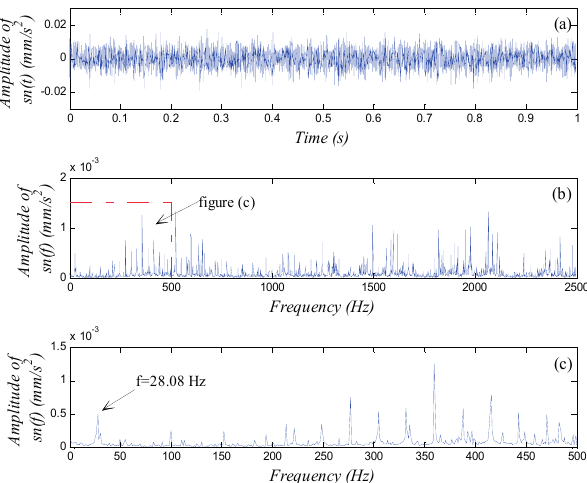
Figure 7. Vibration signal analysis of shaft-bending fault: ( a ) waveform; ( b ) global spectrum; ( c ) low-frequency